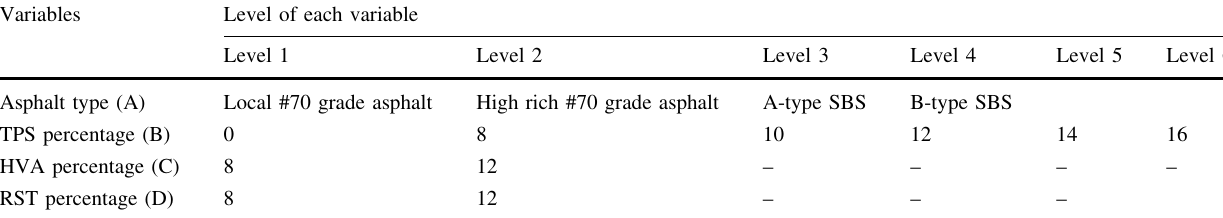
Table 6 Variables and levels of test design Variables